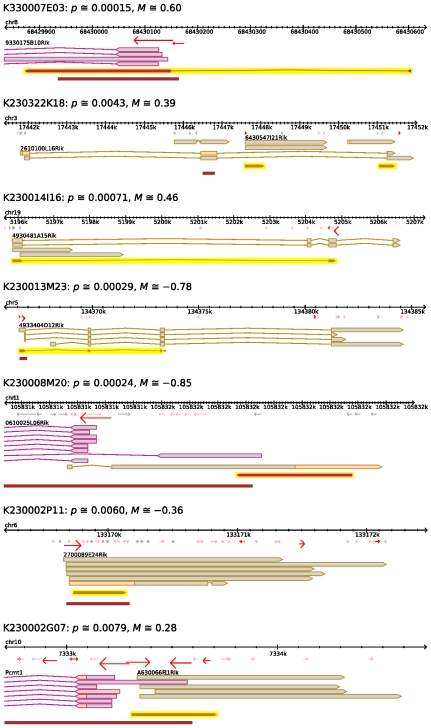
Non-coding clones which show over-representation (M>0) or under-representation (M<0) in the parvalbumin-egfp cells.Pictures extracted from the FANTOM 3 genome browser. The RIKEN clone ID is indicated, followed by the p and M values. Black rulers: chromosomal coordinates. Red arrows: known promoters. Stronger promoters are represented by bigger arrows with a stronger color. Plain arrows: known full-length cDNAs (brown boxing: plus strand; magenta boxing: reverse strand). Pink areas in the cDNAs: predicted coding sequences. The 5′ ends of the selected clones (and the 3′ end, in the case of K23022K18) are represented by plain arrows in a yellow background. K330007E03: clone overlapping the promoter of a coding gene. K230014I16: variant of a spliced non-coding gene. K230322K18: intronic clone overlapping the last exon of a coding gene. K230002G07: unspliced clone sharing the promoter of a coding gene in a head-to-head arrangement. K230002P11: intergenic clone. The coding sequence detected in one of the cDNAs is unlikely to be productive as the ATG is starting the transcript. K230013M23: spliced clone matching cDNAs with no known coding sequence. K230008M20: clone forming a sense-antisense chain with two genes oriented head-to-head.